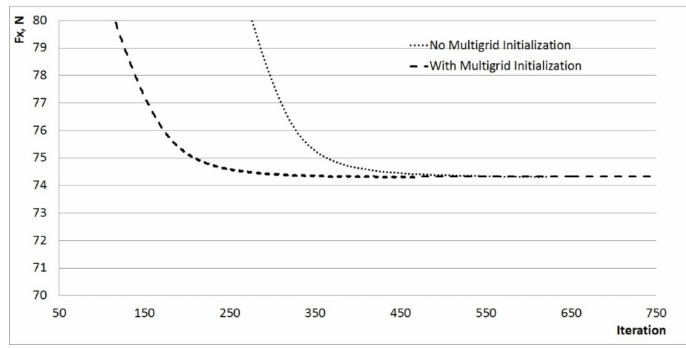
Figure 23. Drag convergence (LM1021).